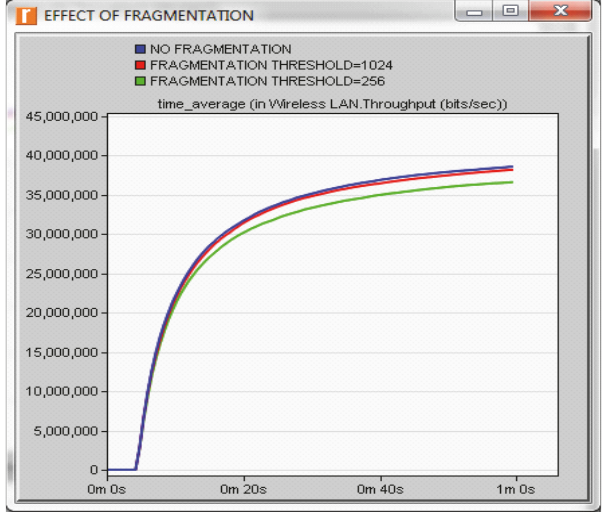
Figure 14: WLAN delay with different fragmentation thresholds and without fragmentation.